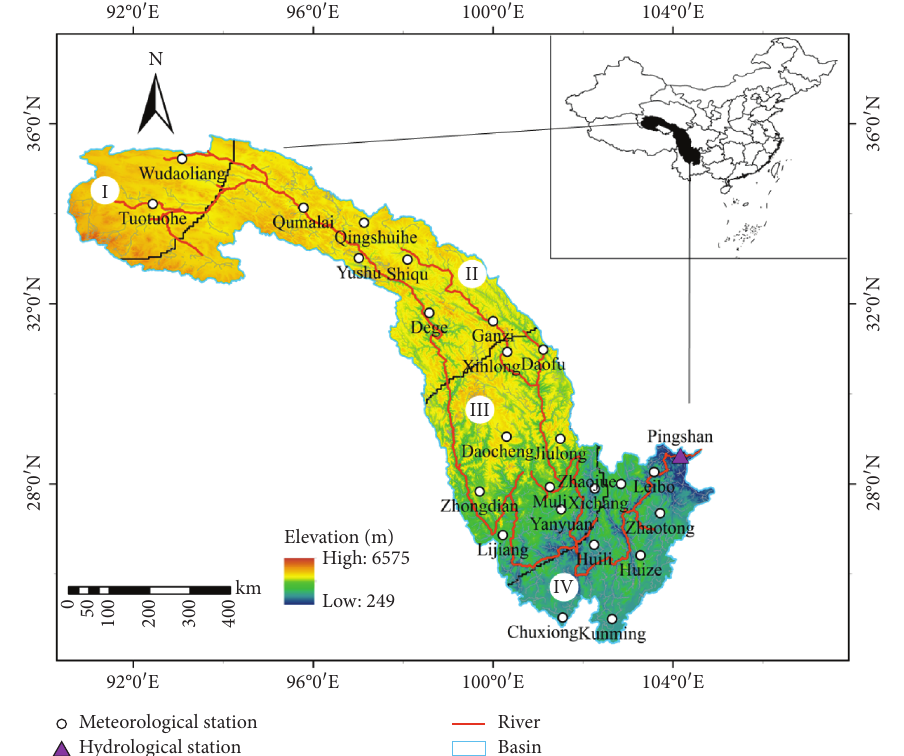
Figure 1: Geographical location of the Jinsha River Basin, the distribution of meteorological stations, and four subregions, including the northwestern (I), the midnorthern (II), the midsouthern (III), and the southeastern